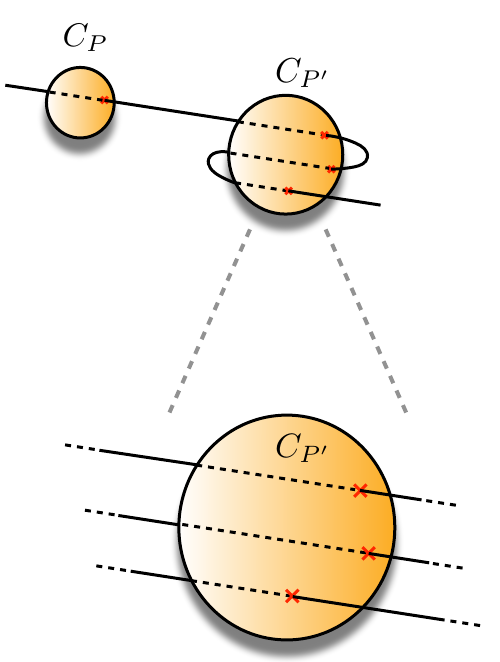
Figure 3 . A globally de(cid:12)ned generator of Pic( Y ) can intersect the resolution curve C C P N times (top frame). However, in a local patch around the curve C P 0 the generator of Pic( Y P ) (bottom 0